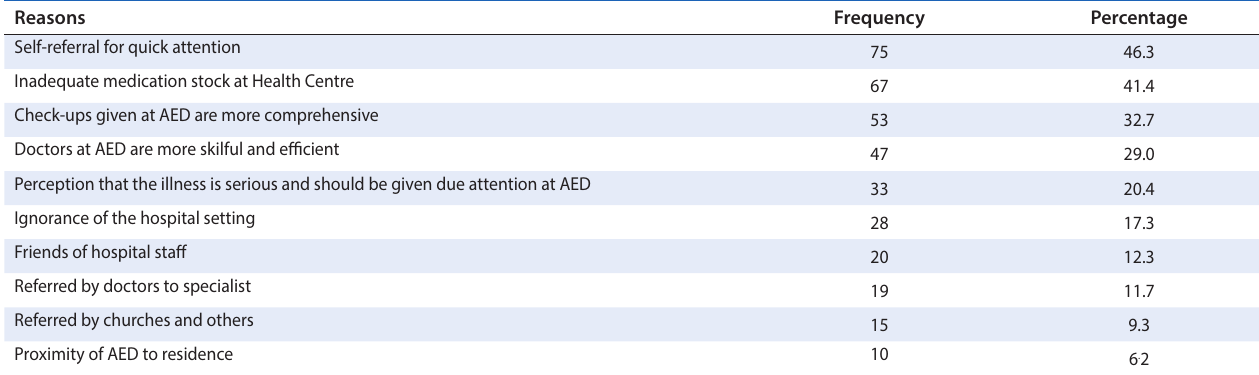
Table 5: Reasons for attending the AED inappropriately